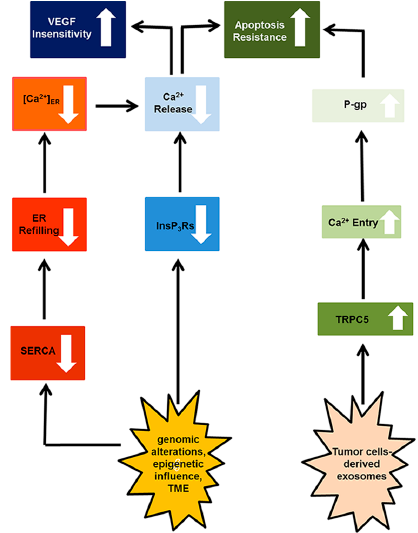
Figure 2. The endothelial Ca 2+ transportome is remodeled to promote tumor endothelial cell resistance to apoptosis. The sequence of events is illustrated by the black arrows. Downward arrows indicate the down-regulation of a specific Ca 2+ -permeable channel/transporter or of a precise cellular process. Upward arrows indicate the over-expression of a specific Ca 2+ -permeable channel or the stimulation of a precise cellular process.